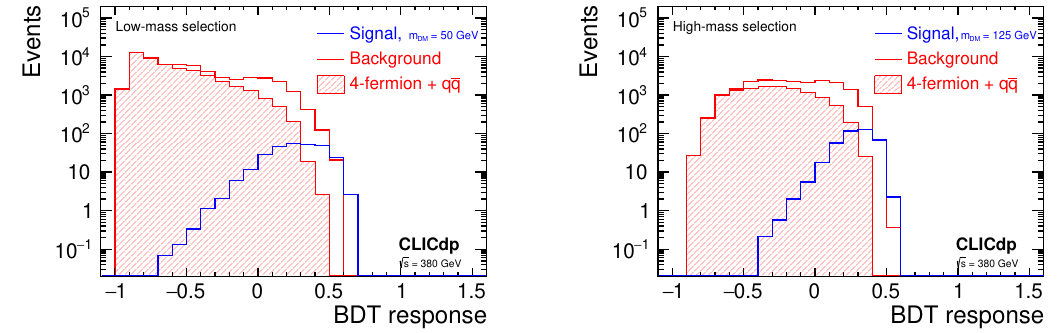
Figure 31. Response distributions of the BDT classi(cid:12)ers used for the (cid:12)nal selection of t ! cE = p events at s = 380 GeV, for an assumed mass of the invisible decay product of 50 GeV (low mass selection; left) and 125 GeV (high mass selection; right). The total background (red histogram) is normalised to 1.0 ab (cid:0) 1 while the signal (events with a FCNC top quark decay; blue histogram) is normalised to BR(t ! cE = ) = 10 (cid:0) 3 . The hatched histogram indicates the contribution from four fermion and quark-pair backgrounds.